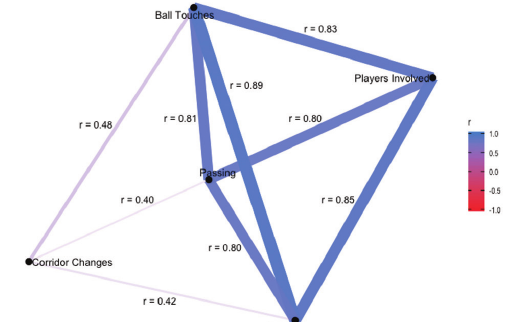
Figure 3. Correlation network analysis among tactical and technical variables in offensive sequences that finished in success